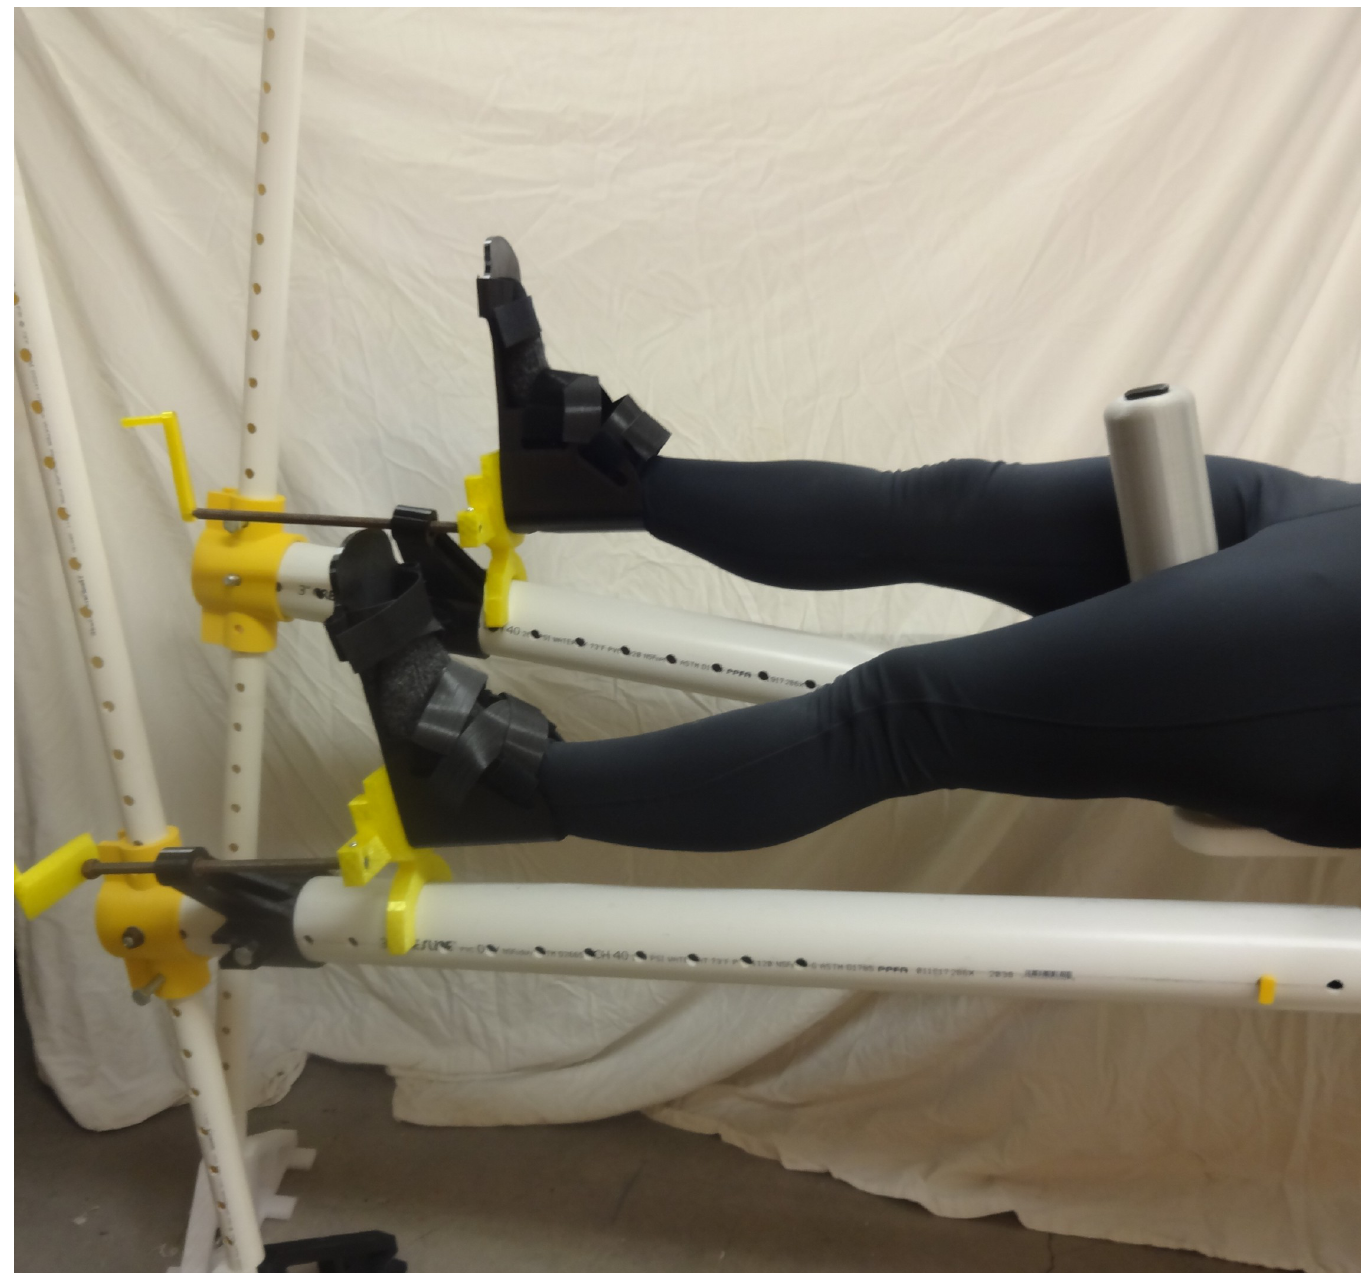
Fig 31. Details of one leg straight and one leg straight down